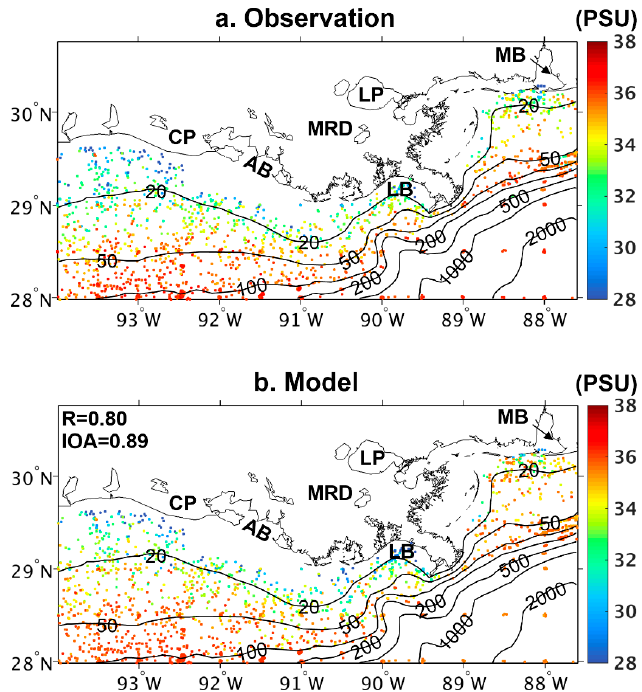
Figure 6. Depth-averaged salinity comparison between observations (data source: SEAMAP; http: // seamap.gsmfc.org) and model results in the nGoM in 20 yrs. (AB: Atchafalaya Bay; MRD: Mississippi